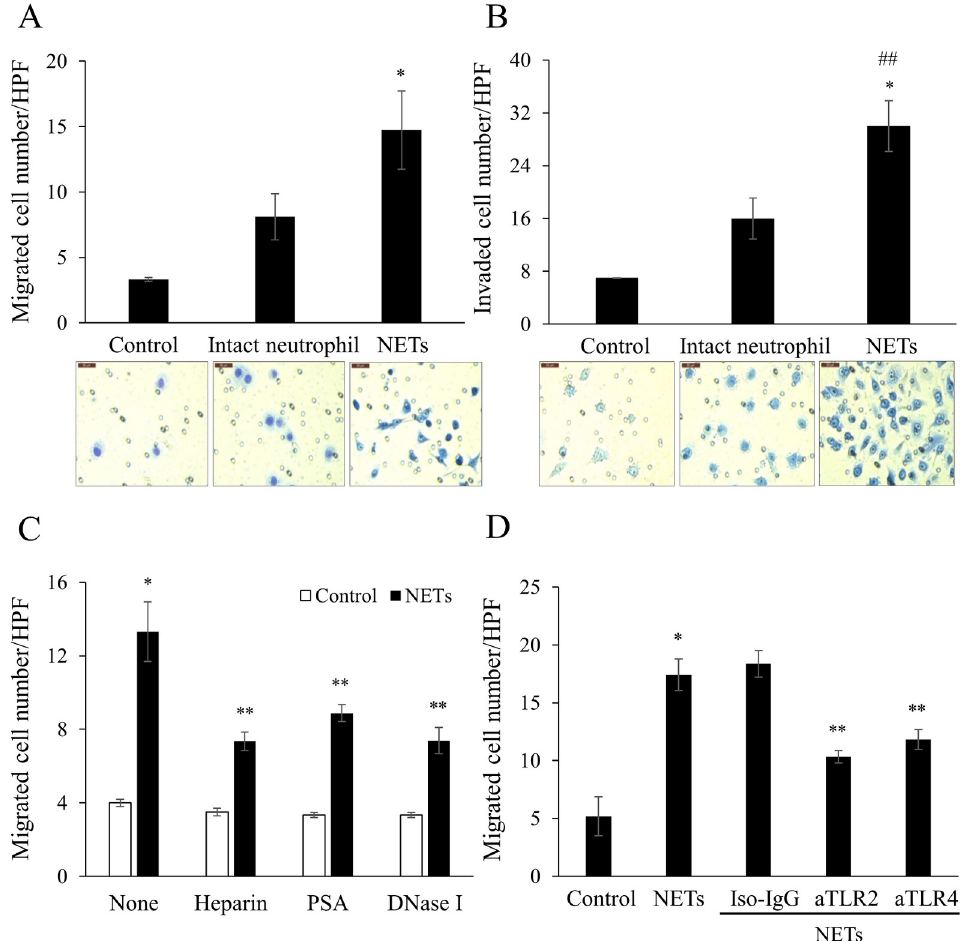
Fig 4. NETs promote migration and invasion of pancreatic cancer cells. Intact isolated neutrophils (3.3 × 10 5 cells/ mL) and NETs (300 mg/dL final protein concentration) were used as chemoattractants. They were added to the lower chambers of (A) an uncoated transwell and (B) rehydrated Matrigel–coated transwell. AsPC-1 (2 × 10 5 cells/mL) were added to upper chambers. After 22 h incubation, the (A) migrated and (B) invaded cells were stained with Diff-Quik kit and imaged under an optical microscope ( × 400). Averaged data of six randomly selected high-power fields (HPF) are shown. Scale bar: 50 μ m. Statistical analysis was performed by one-way ANOVA followed by Bonferroni’s post-hoc test. � P < 0.05 versus control; ## P < 0.05 versus intact neutrophil. (C) NETs were pre-treated with heparin (200 IU/mL), polysialic acid (PSA, 62.5 μ g/mL), or DNase I (50 IU/mL) and then the migration assay was performed. (D) AsPC-1 cells were pre-treated with mouse IgG 2a,K antibody (Iso-IgG, 50 μ g/mL), anti-Toll-like receptor-2 (aTLR2, 50 μ g/mL), or anti-TLR4 (aTLR4, 50 μ g/mL) and then the migration assay was performed. The numbers of migrated or invaded AsPC-1 cells are shown as mean ± SEM of 3 experiments. � P < 0.05 versus control; # P < 0.1 versus control; �� P < 0.05 versus NETs.